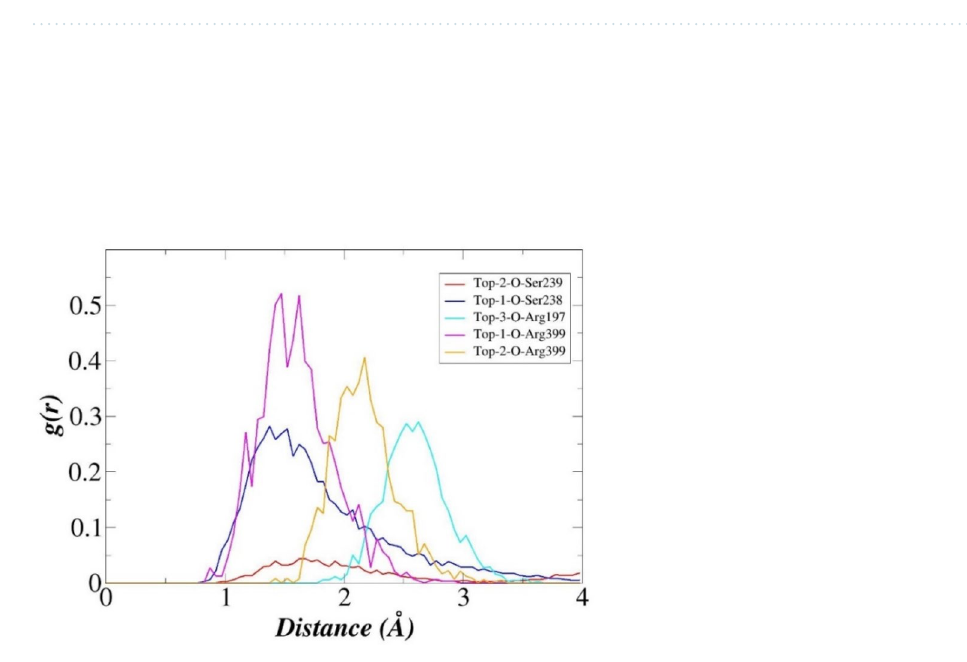
Figure 6. Molecular dynamics simulation of EPSP synthase in the presence of control. ( A) RMSD, and ( B) RMSF.